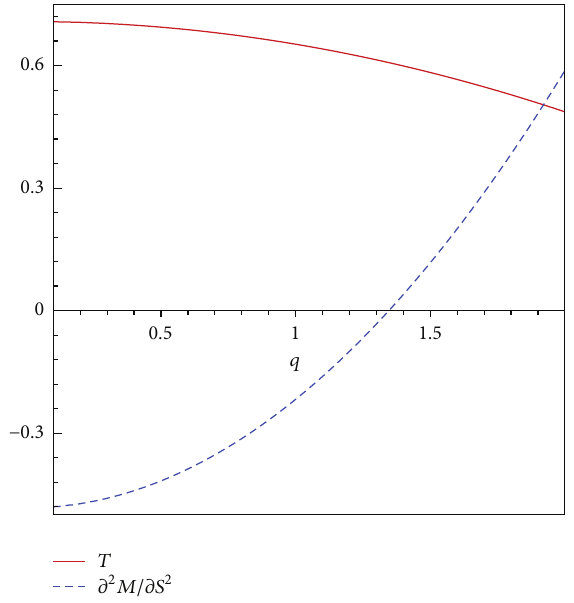
Figure 10: The behaviors of 𝑇 and (𝜕 2 𝑀/𝜕𝑆 2 ) 𝑄, J versus 𝑞 with 𝑙 = 𝑏 = 1 , 𝛼 = 1.5 , Ξ = 1.25 , 𝑛 = 5 , 𝛽 = 5 , and 𝑟